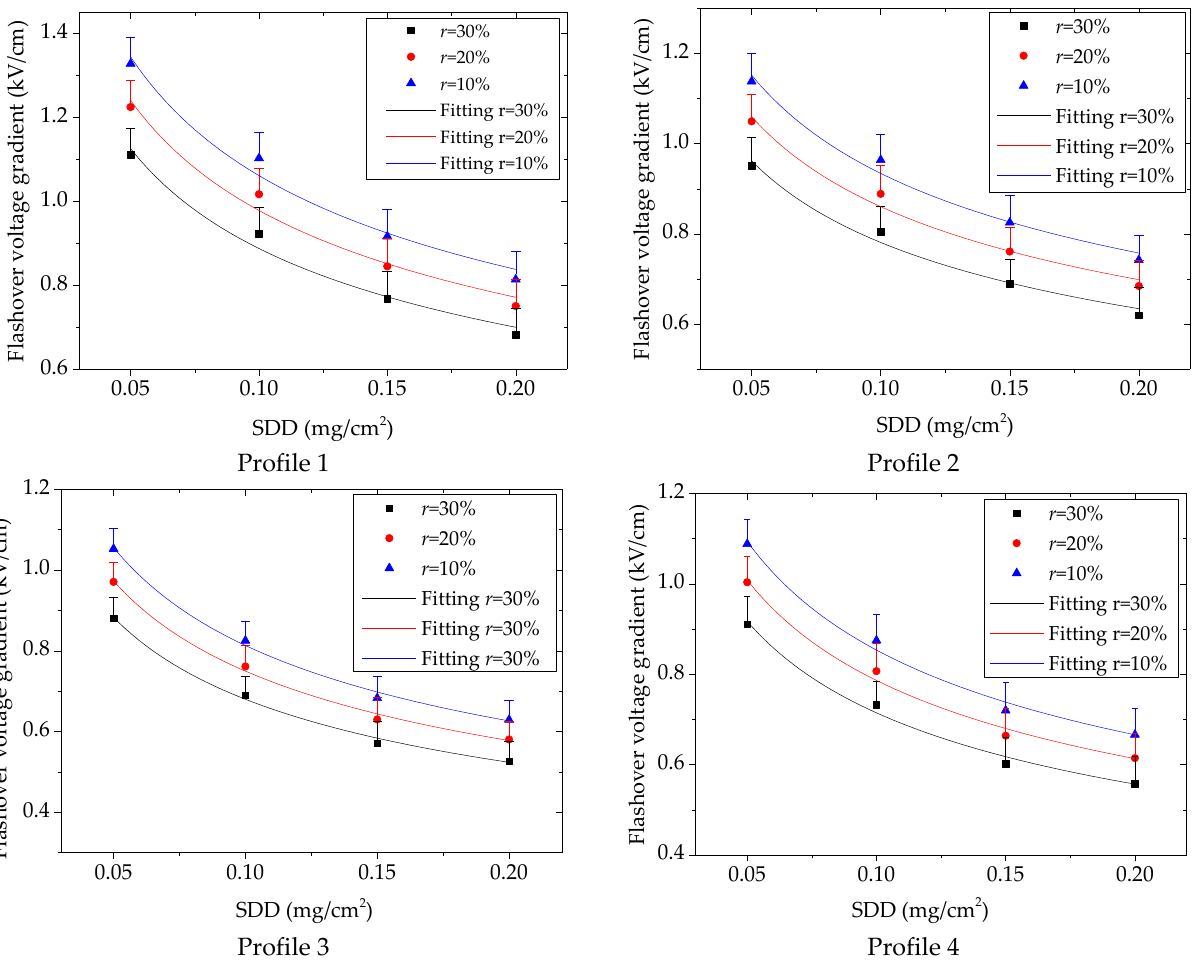
Figure 8. The flashover voltage gradient E F versus SDD for various profiles of coating damage. The fitting results of SDD and E F obtained with the test results are shown in Table 3. According to value of constant “ a ” in Equation (6), the pollution properties indicator “ b ” and the correlation coefficient R 2 of four various kinds of coating damage profiles on